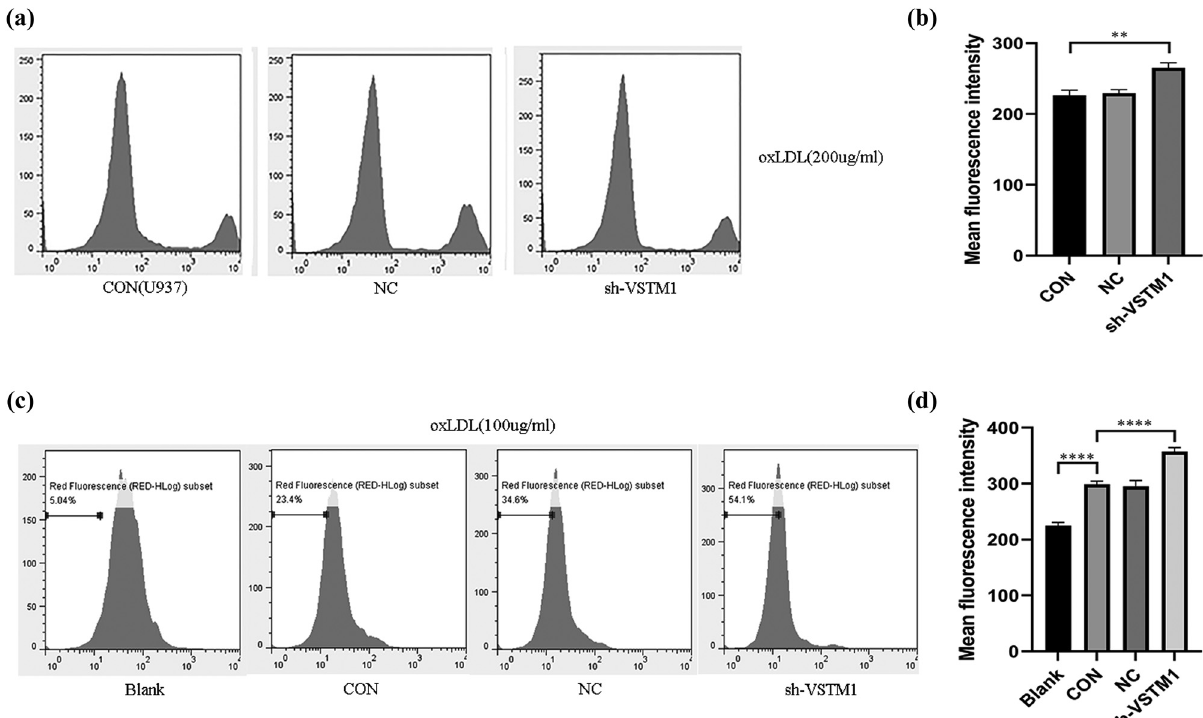
Figure 3: E ff ects of sh - VSTM1 on ROS production and lipid phagocytosis of monocytes/macrophages stimulated by ox - LDL. ( a ) and ( b ) E ff ects of ox - LDL on ROS production in U937, U937 NC, and sh - VSTM1 U937 cells ( compared with the 293 T group, * p < 0.05, ** p <